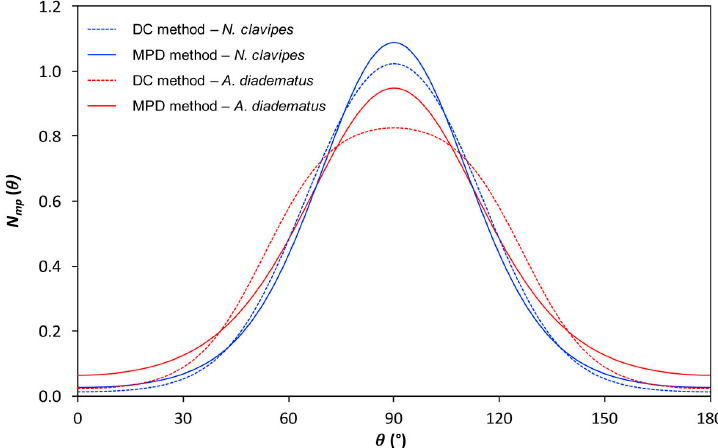
Figure 6. Most probable orientation distribution (MPD) functions, N mp ( θ ), of the carbonyl groups as determined from the order parameter values (Table 1) of Nephila clavipes and Araneus diadematus MA silk fibers according to the MPD and depolarization constant (DC) methods.